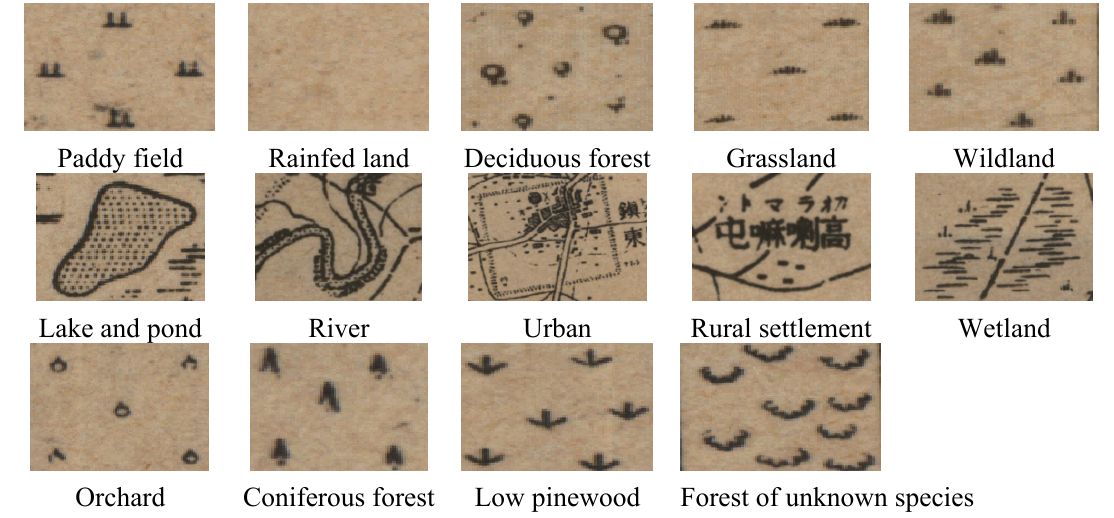
Figure 2. Legends of topographic maps at scale 1:100,000 in the